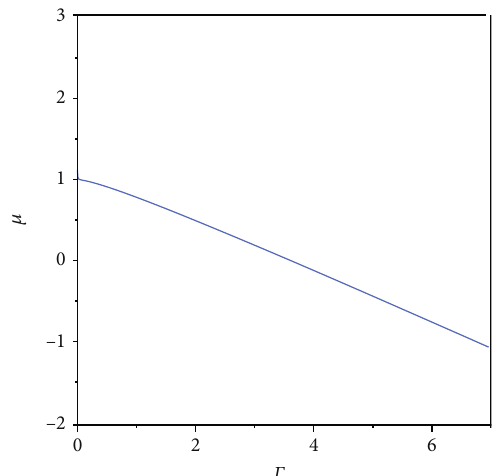
Figure 4: Single-soliton shape variations for di ff erent values of the coupling parameter, Γ = 250 (solid line), Γ = 170 (dot line), and Γ = 100 (dashed line). σ = 0 : 1 , δ = 10 , and k = 0 : 8